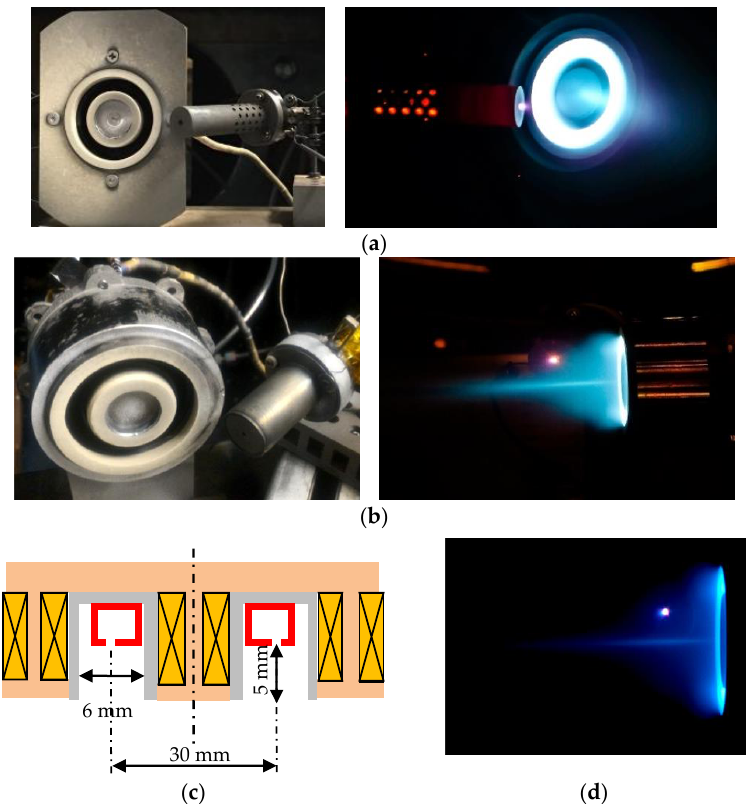
Figure 6. 200 W-class Hall thrusters: ( a ) initial thruster design operating with the PSAC cathode; ( b ) optimized thruster design operating with an upgraded version of the PSAC cathode; ( c ) schematic of the thruster with the main dimensions (not at scale) and with internal and external magnetic coils; ( d ) plasma plume of the optimized thruster in high specific impulse mode, operating with Xe at 200 W.